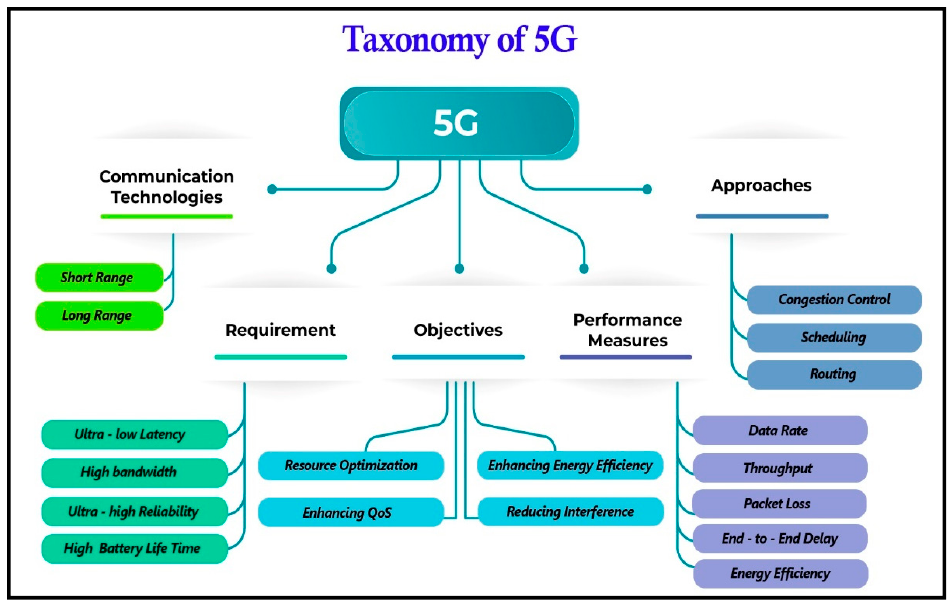
Figure 7. Taxonomy of 5G.